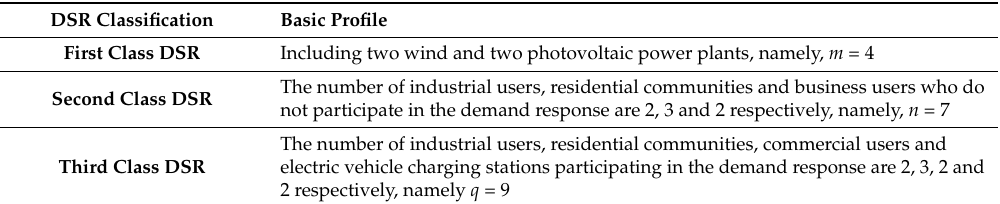
Table 2. The basic profiles of all types DSR.